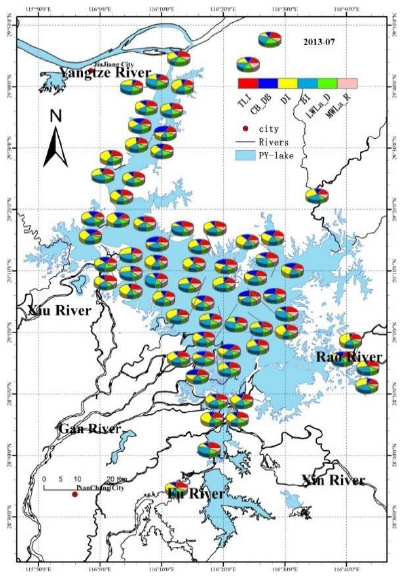
Figure 8. Assessment weights of the aquatic ecosystem in Poyang Lake in June 2013.